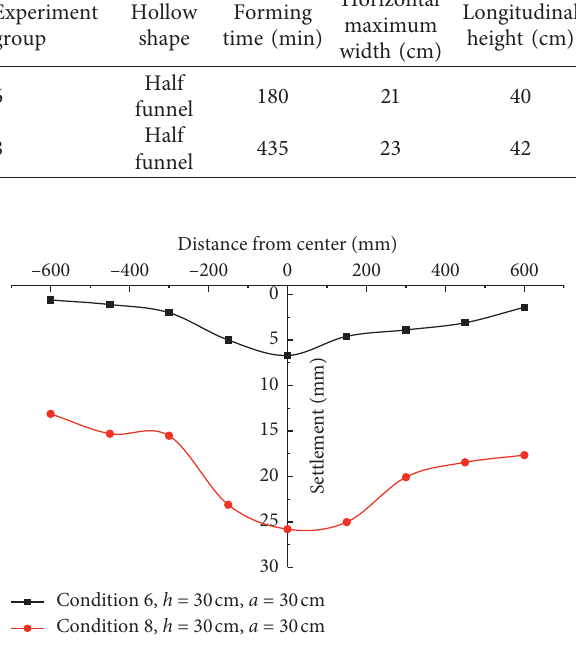
Figure 14: Effect of formation time of loss channel on settlement